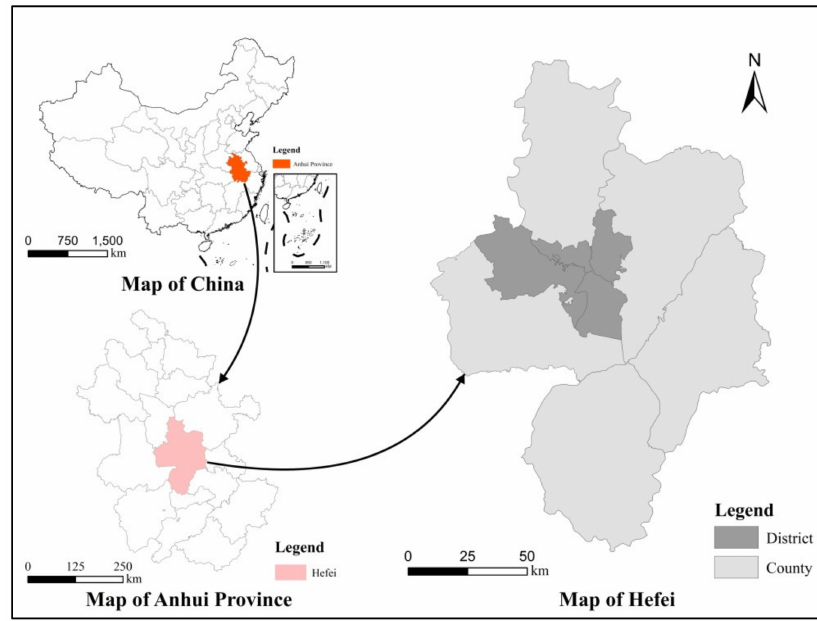
Figure 2. Geographical location of